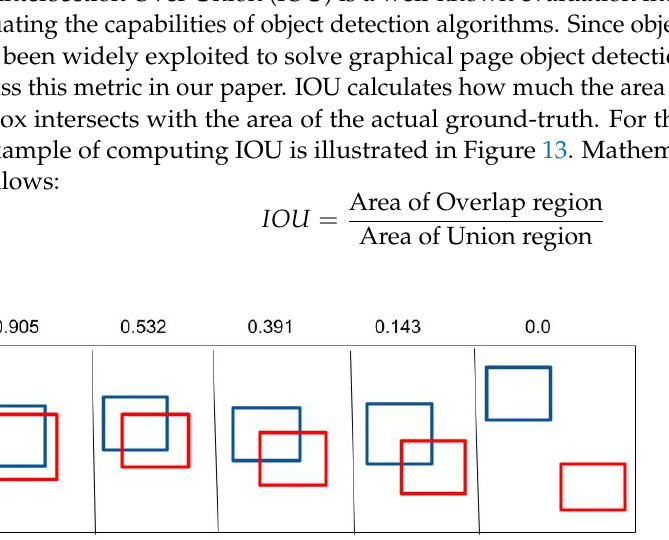
Figure 13. Visual illustration of IOU in object detection methods. The bounding box with blue color represents the ground-truth whereas the bounding box with red color denotes the predicted bounding box. Considering the IOU threshold set to 0.5, only the first two predictions from the left will be considered true positives whereas the rest of them will be treated as false positives.